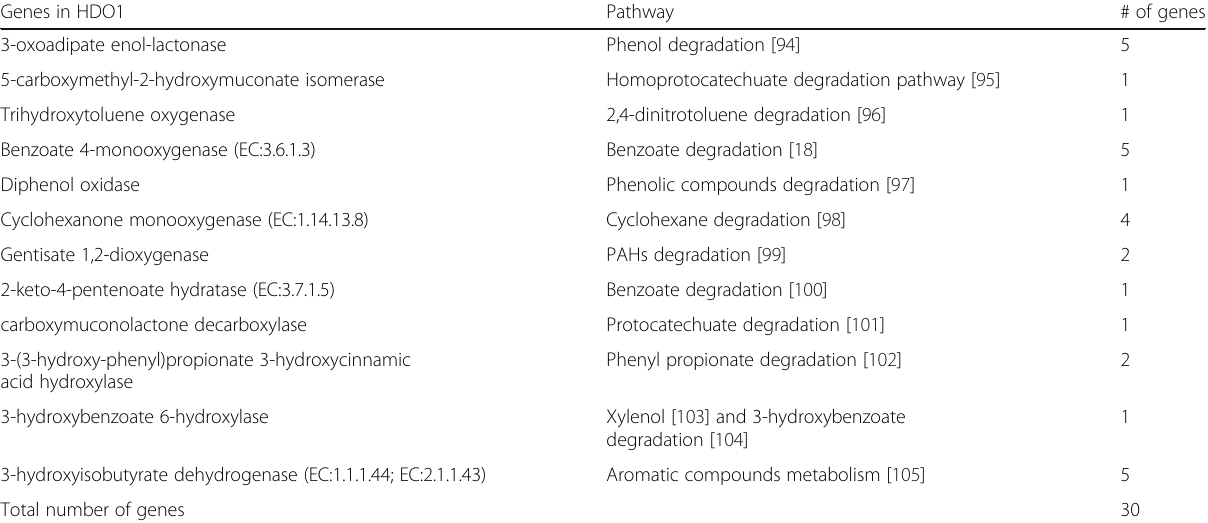
Table 7 Annotated genes found only in the HDO1 strain Genes in